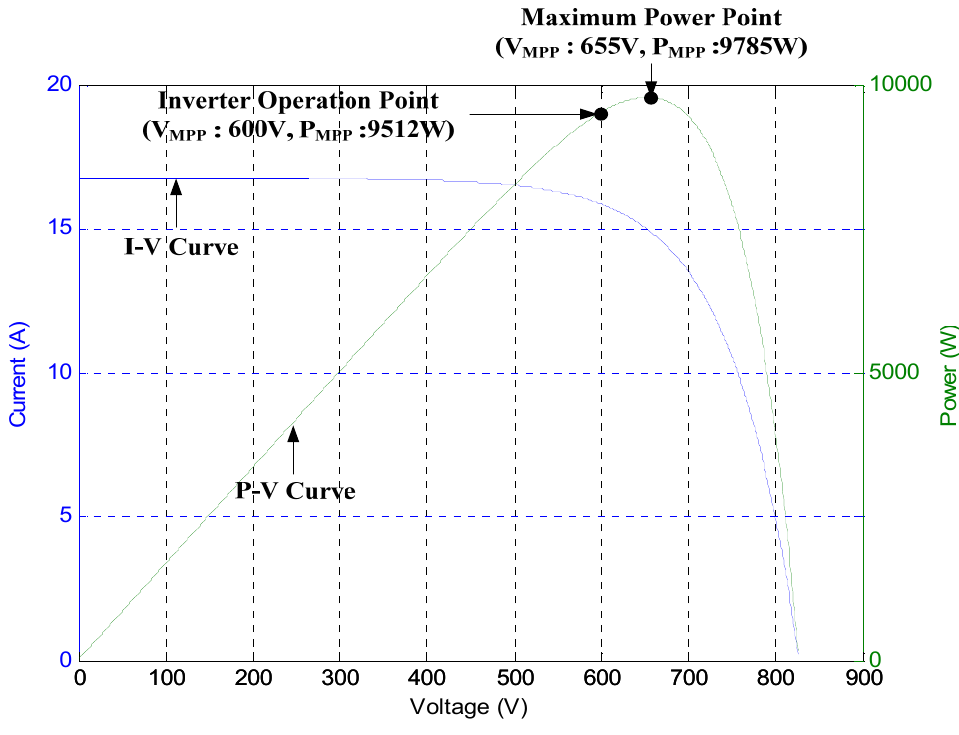
Figure 7. The inverter operation point and the maximum power operation point in the PV cells characteristic curve.